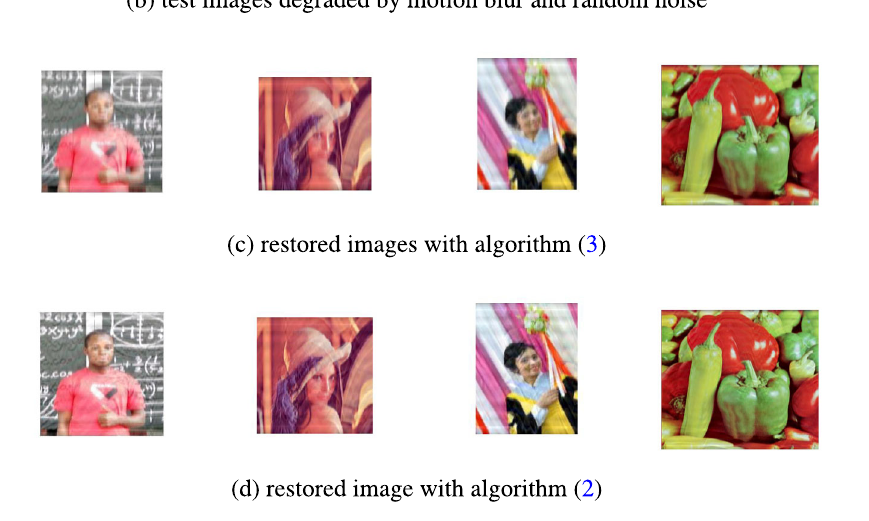
Figure 1 Restoration process via algorithms (3) and (2)